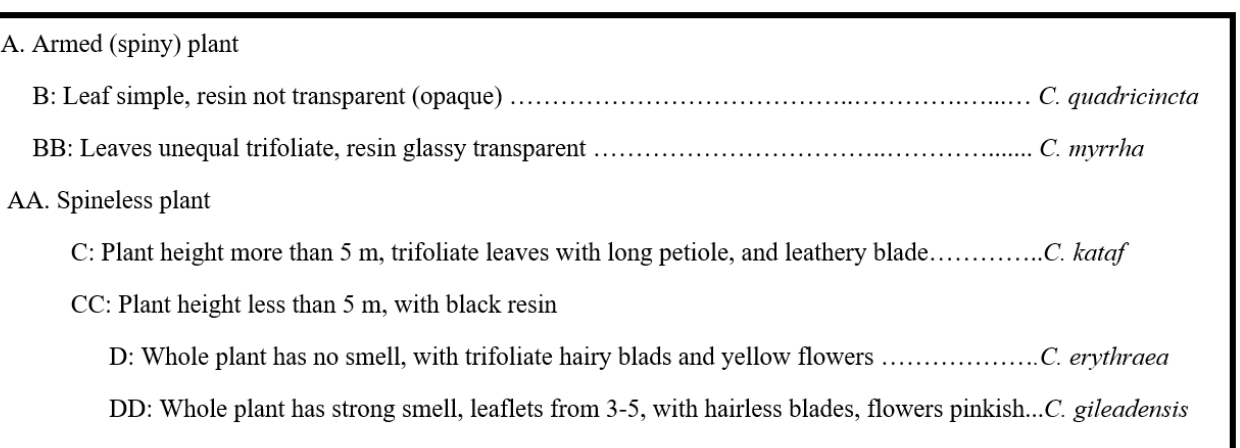
Figure 8. Identification key of Commiphora species based on gross morphology.